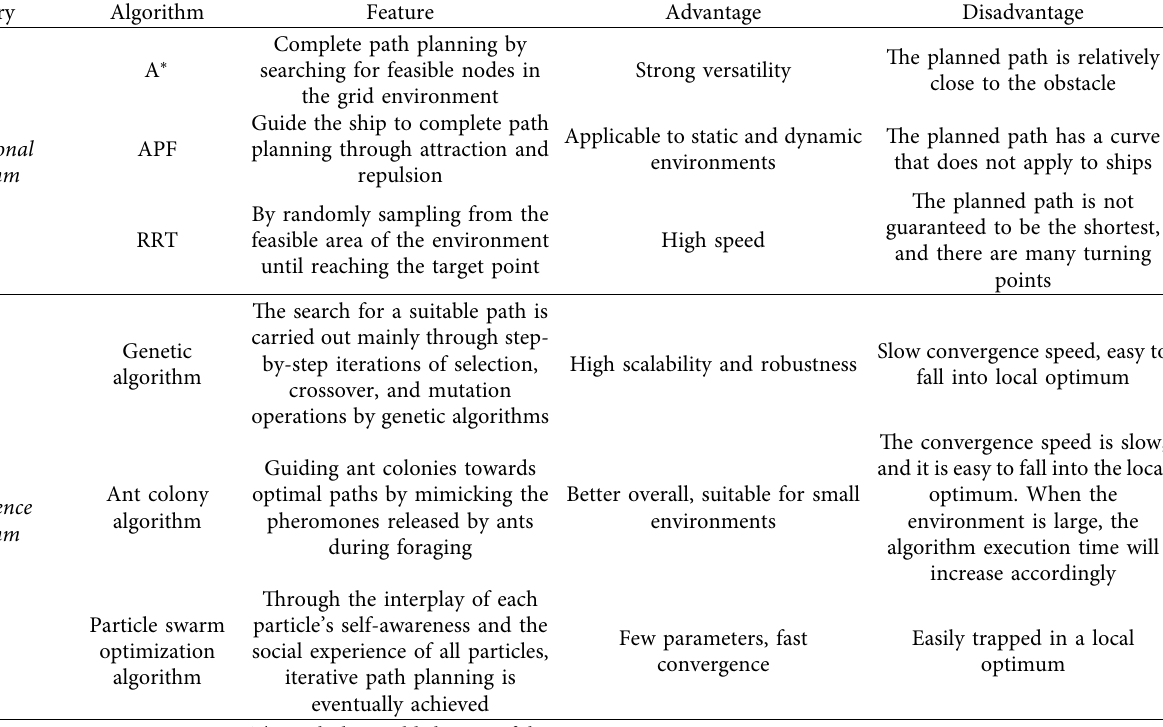
Table 1: Comparison of the existing ship path planning